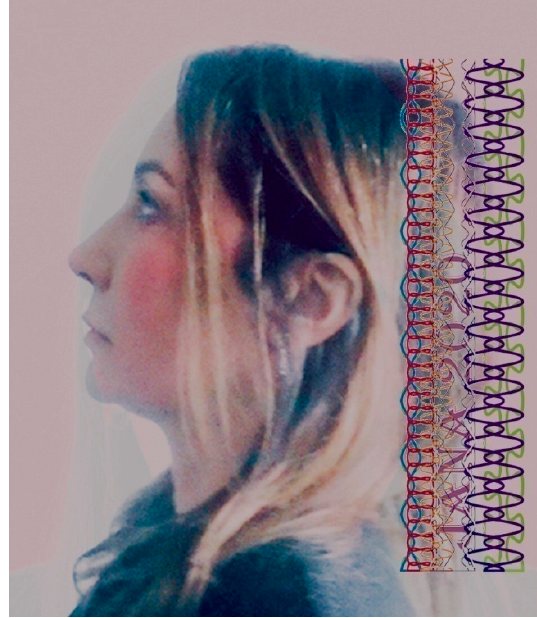
Figure 8. Visible presentation CMYK.